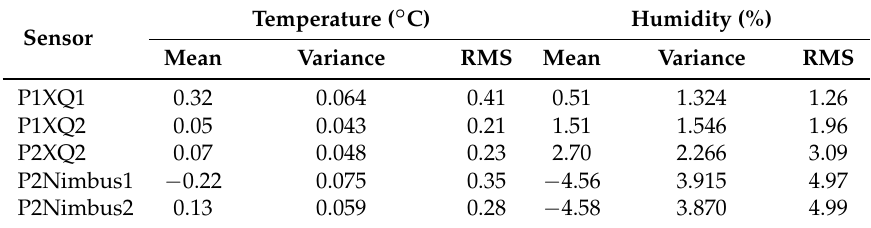
Figure 8. A comparison of the sensor readings with the MURC tower: The data presented here summarizes 10 minutes of hover at the MURC tower altitude (15.2 m) as presented in Figure 7. (S1—P1XQ1 (housing), S2—P1XQ2 (housing), S3—P2XQ2 (housing), S4—P2Nimbus1 (no housing), and S5—P2Nimbus2 (housing)). Table 3. The key statistics for the MURC calibration error ( MURC − Sensor